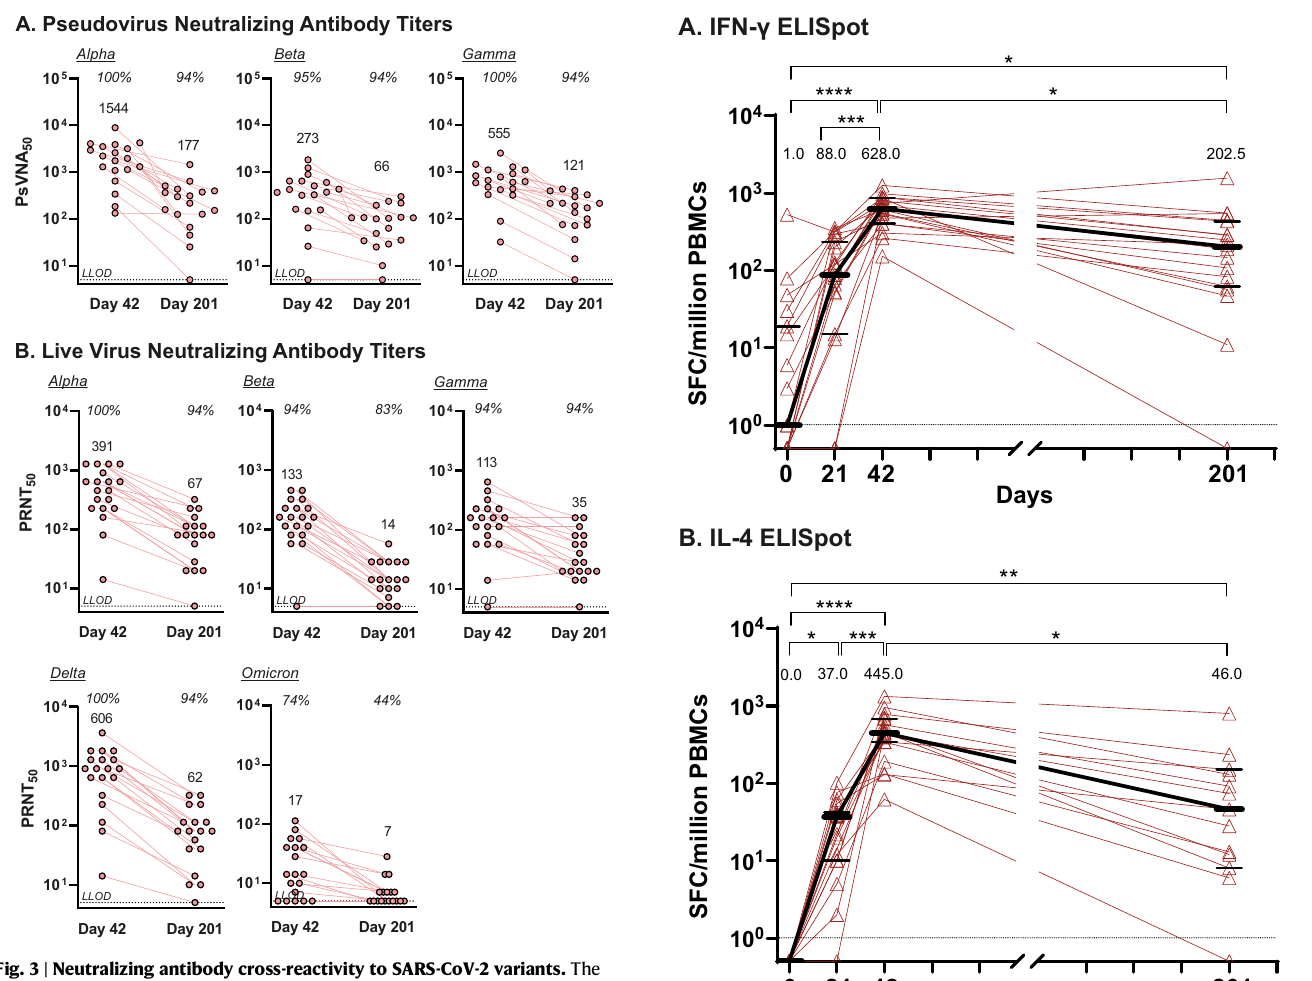
Fig. 3 | Neutralizing antibody cross-reactivity to SARS-CoV-2 variants. The cross-reactivity ofNAbs in subjects vaccinated with 3.75 µ g CoVLP adjuvantedwith AS03 ( n =19 at D42, n =18 at D201) were quanti fi ed by ( A) VSV pseudovirion neu- tralization assay against the Alpha, Beta, or Gamma variants or by ( B) live virus neutralization assay against the Alpha, Beta, Gamma, Delta and Omicron variants. Individualvaluesarerepresented;geometricmeansareindicatedaboveeachseries of datapoints. Percentage seropositivity relative to the variant being tested are shown at the top of each